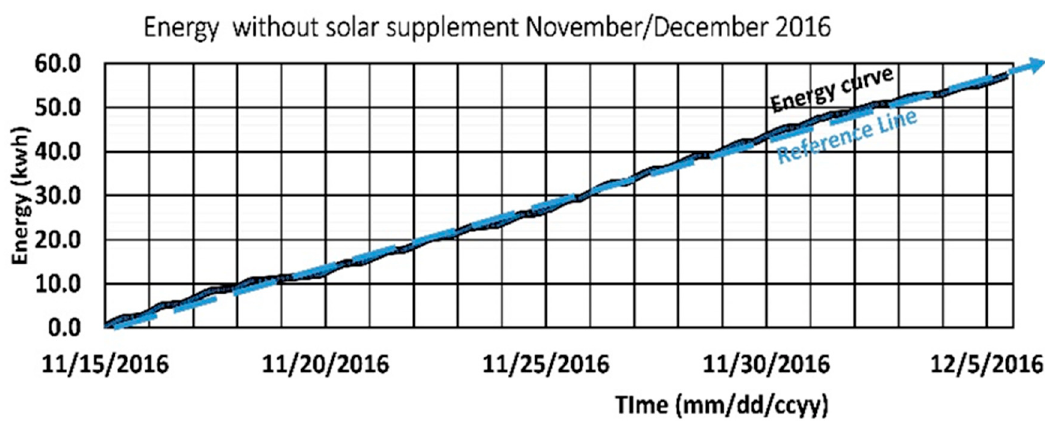
Figure 12. Accumulative energy consumed from commercial source that is not supplemented by solar energy.